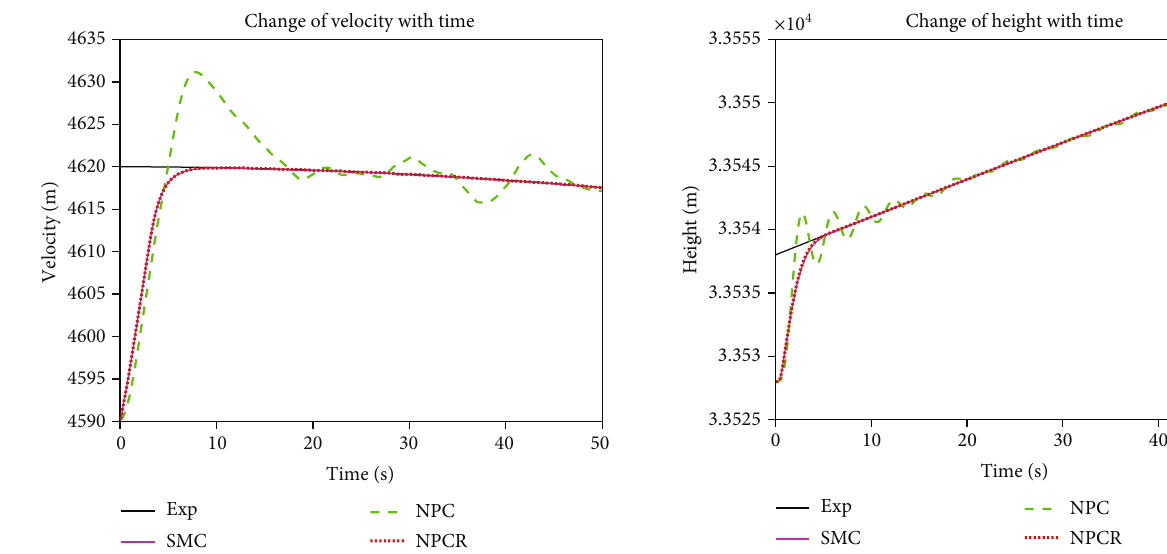
Figure 11: Height changes with time under di ff erent controllers.